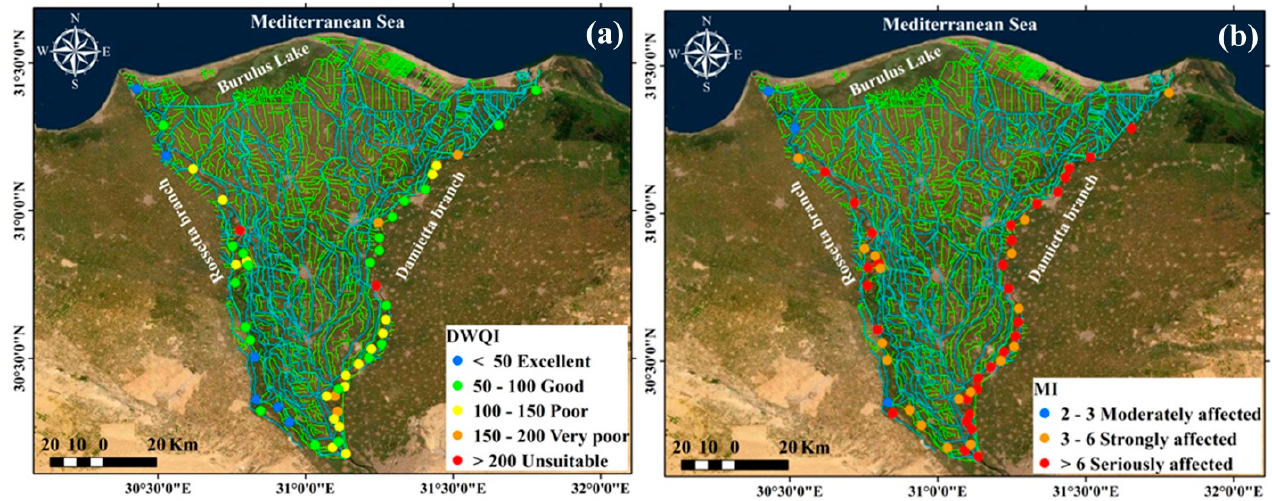
Figure 6. Spatial distribution maps of water quality indices (WQIs) along the Nile River: ( a ) drinking water quality index (DWQI) and ( b ) metal index (MI).